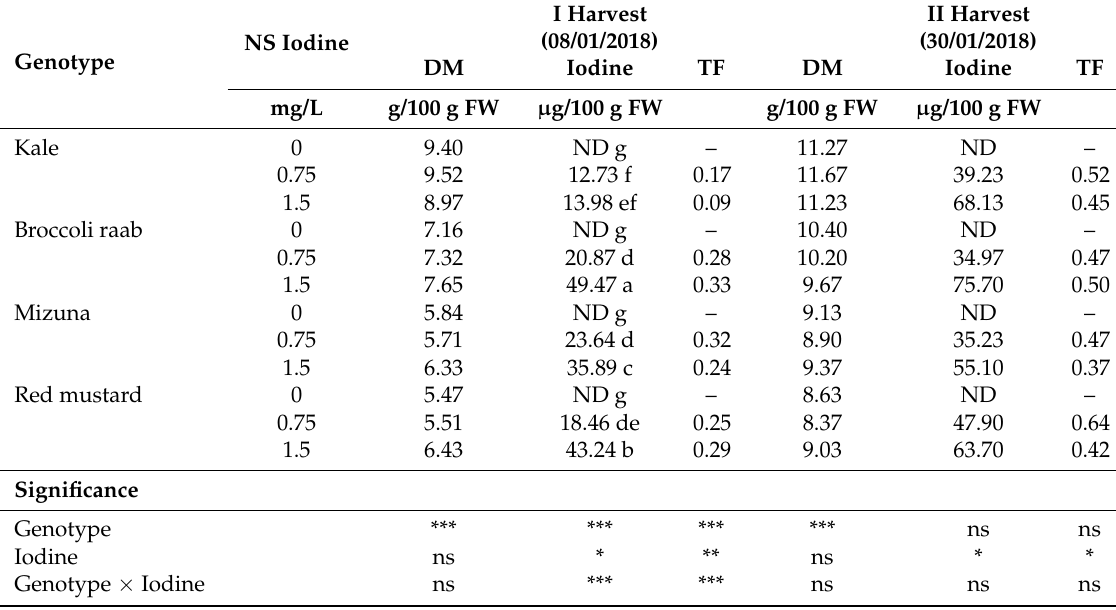
Table 2. Dry matter (DM), I concentration, and transfer factor (TF) of Brassica genotypes supplied with different levels of I in the nutrient solution (NS), measured after 21 and 43 days after iodine biofortification (I and II harvests).